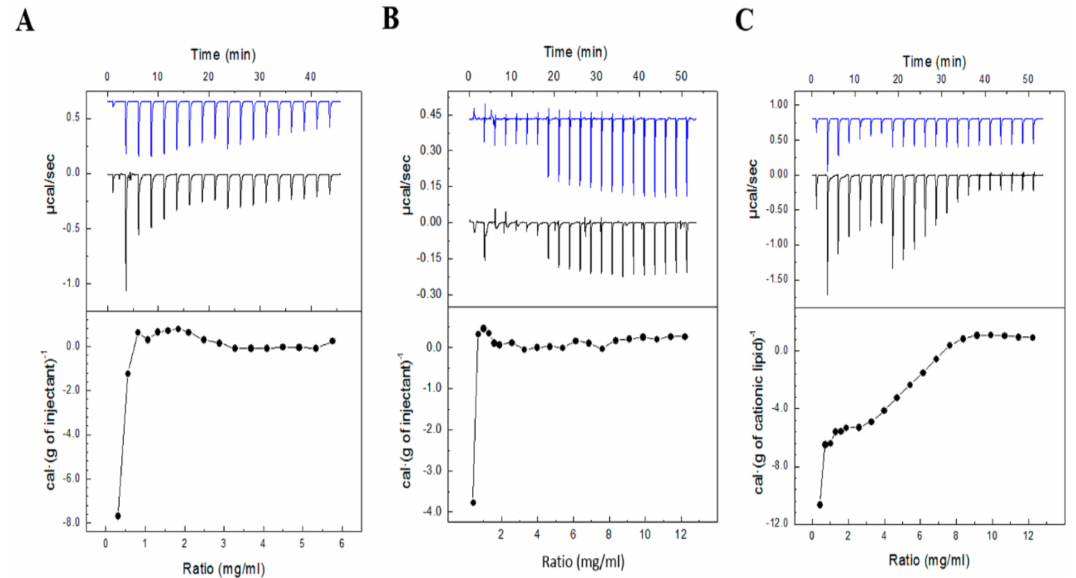
Figure 6. Isothermal titration calorimetry (ITC) of ( A ) formulation 1 (1:1 dilution), ( B ) formulation 2 and ( C ) formulation 3 into pEGFP. Upper panels show the raw data for the injection of respective formula into the plasmid solution (black line) or the blank solution (blue line). Lower panels show the dependence of the heat evolved by gram of cationic lipid injected as a function of the DTPA/pEGFP mass ratio in the sample cell (measures were carried out at 25 ◦